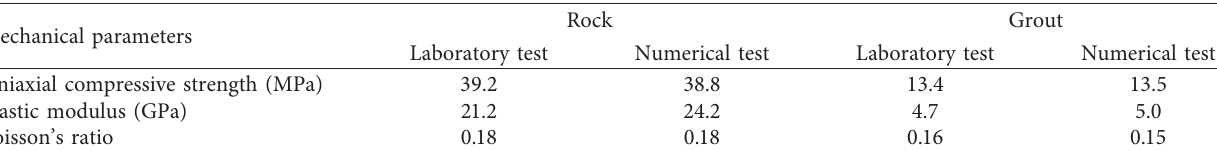
Table 2: Material properties of real and numerical